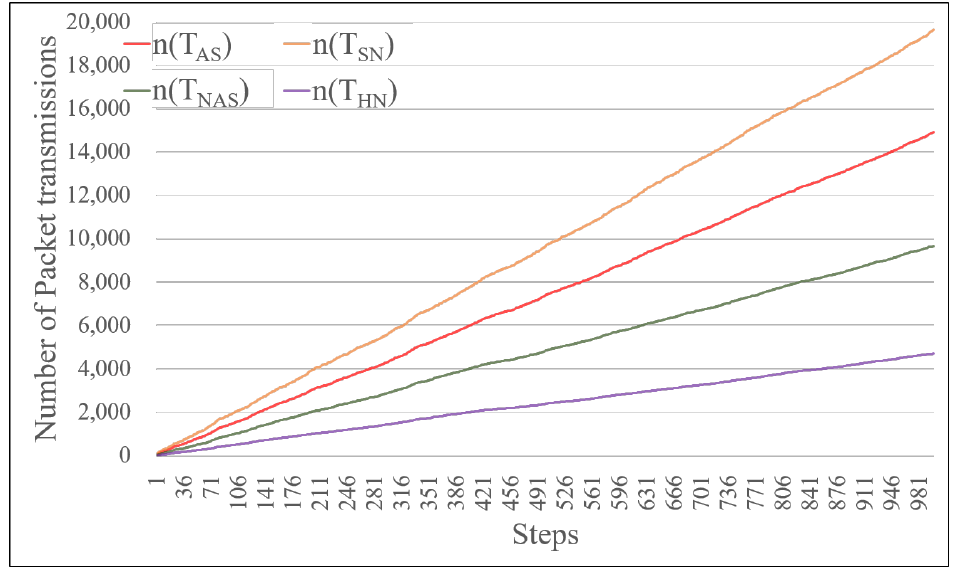
Figure 6. Number of packets generated by the proposed secondary authentication framework.